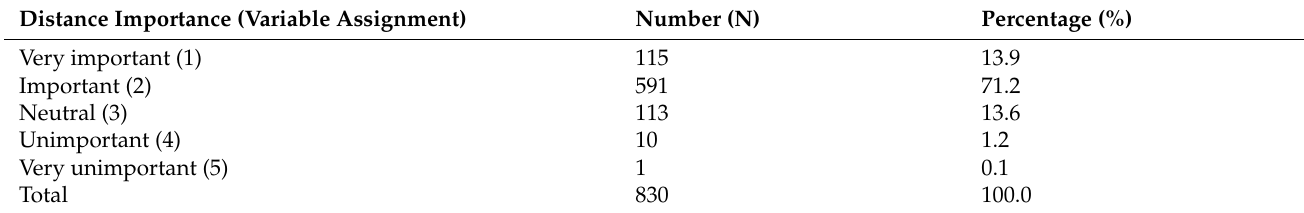
Table 3. Statistics of the elderly’s preference for distance.